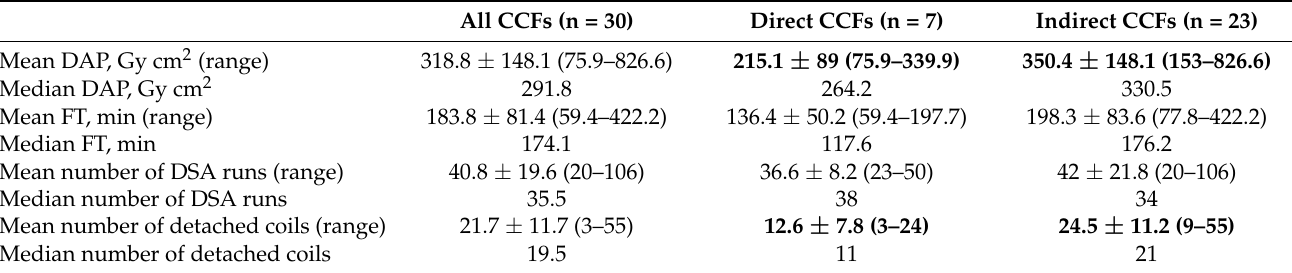
Figure 1. Box plots and scatter plots of total DAP, FT, number of implanted coils, and DSA acquisitions showing different types of CCFs. Significantly higher DAP ( p = 0.03) and number of implanted coils ( p = 0.02) in the indirect group. No significant difference in FT ( p = 0.08) or number of DSA acquisitions ( p = 0.84) between two groups. DAP: dose area product, FT: fluoroscopy time, DSA: digital subtraction angiography, CCF: carotid cavernous fistula * indicates statistically significant difference. Table 3. Dosimetrics and number of implanted coils.